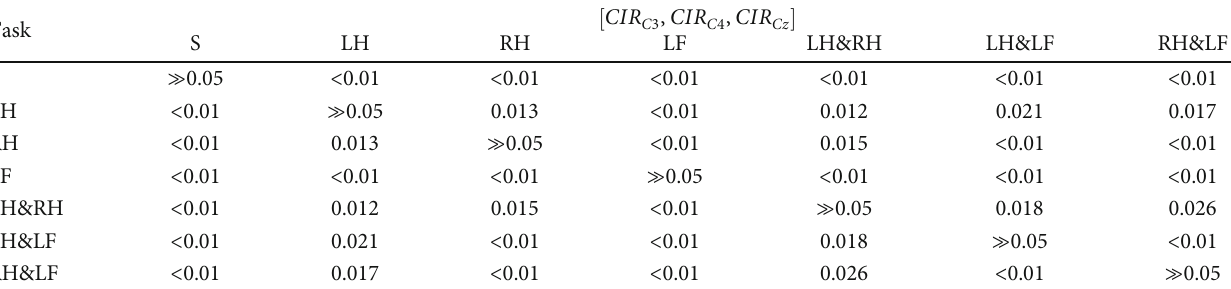
Table 3: p values of the feature vector.